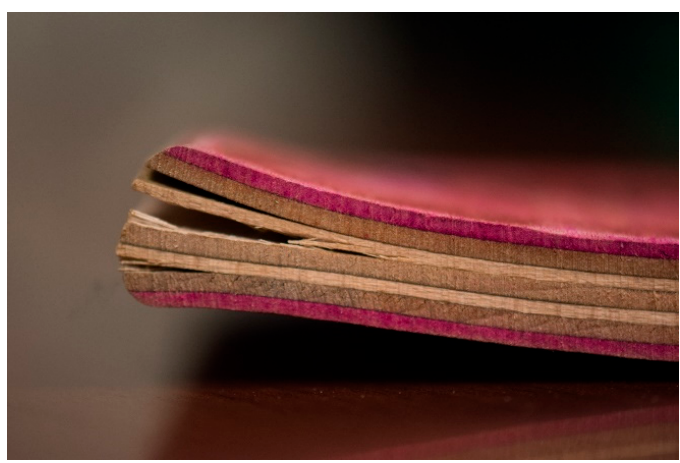
Figure 13. Cross section view of sample 2 showing delamination after soak/dry moisture durability test (ANSI/HVPA EF 2009 [4]).